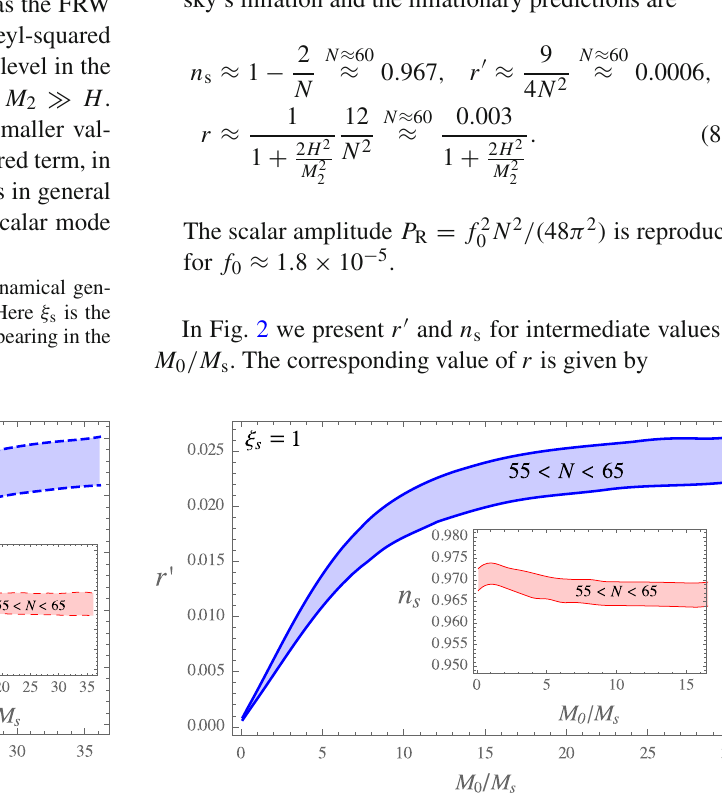
Fig. 2 The ratio r (cid:6) between the isocurvature power spectrum P B of (the gradient of) B and the curvature power spectrum P R as defined in Eq. (7.6), as a function of the ratio between the two mass parameters of ζ and s , respectively, setting the dominant inflaton (as explained in the